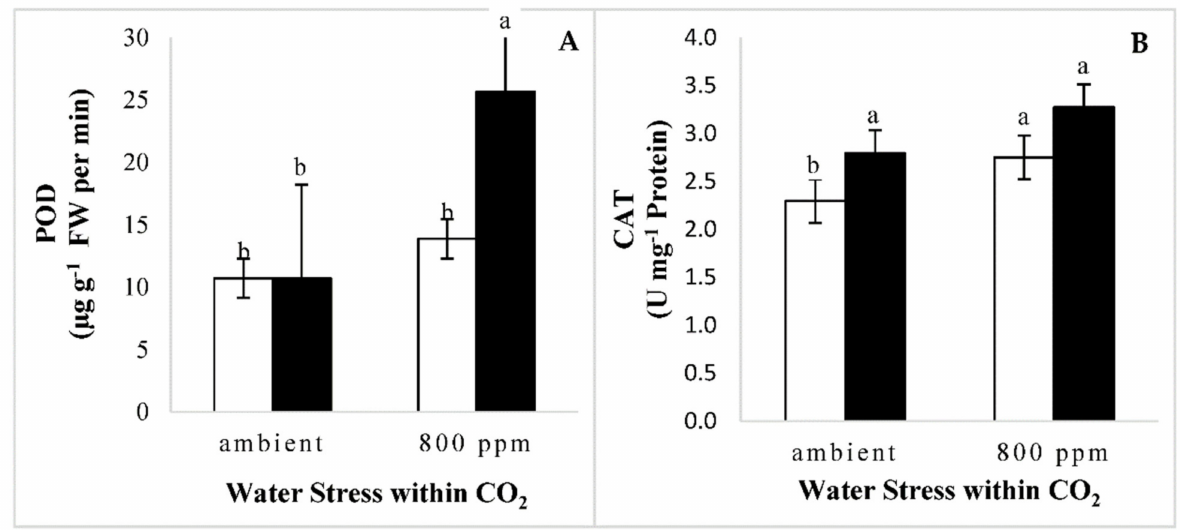
Figure 4. Effect of water stress within CO 2 levels and brassinolide application on Ficus sp. ( A ) POD at third month after treatment (MAT), and ( B ) CAT at third MAT. Bars represent means ± SD. Empty bars are well − watered, and black bars are drought stressed. Bars with different letters are significantly different by Fisher’s LSD at p <